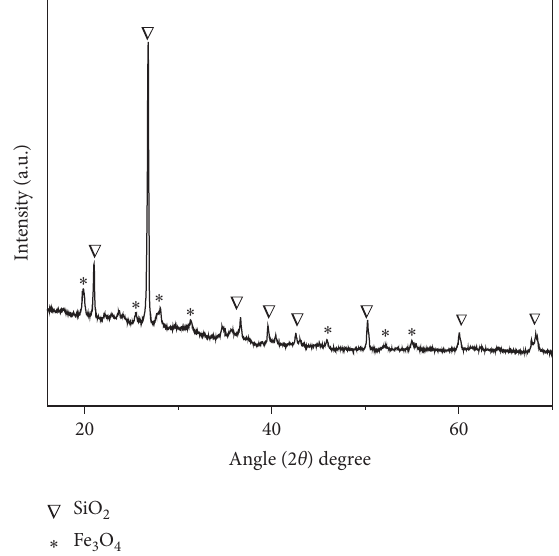
Figure 4: X-ray diffraction (XRD) spectrum of 2 :1